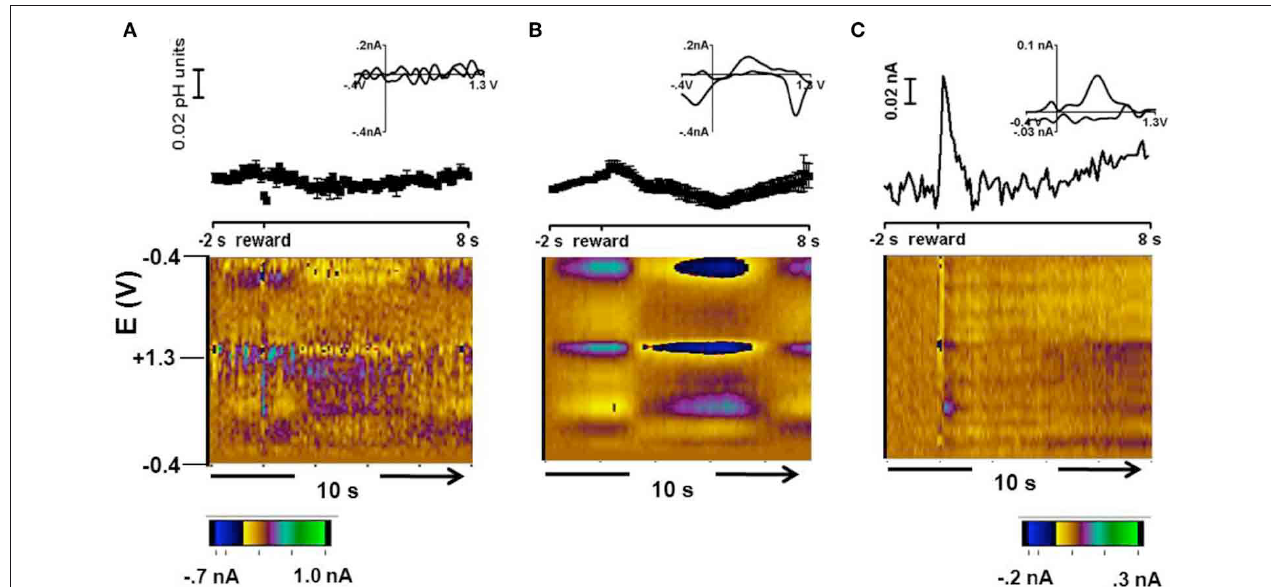
FIGURE 3 | Free reward response. (A) Representative cyclic voltammogram (top, inset), concentration vs time (middle), and average color plot at two locations where there was no change following the free reward. (B) Representative cyclic voltammogram (top, inset), concentration vs. time